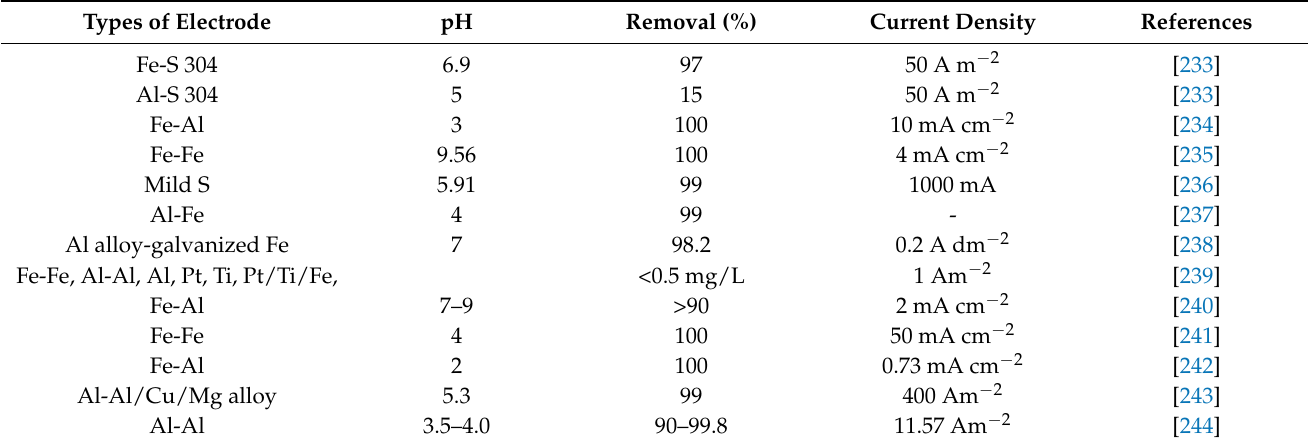
Table 4. Removal of Cr by electrocoagulation